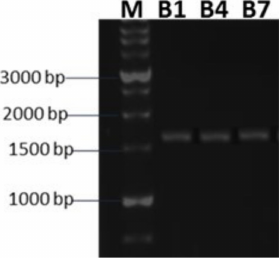
Figure 1. Agarose gel electrophoresis of the amplified PCR fragment for 16 r DNA gene. M: 1 kb DNA marker, isolates with code no. (B1, B4 and B7) (MW~1550